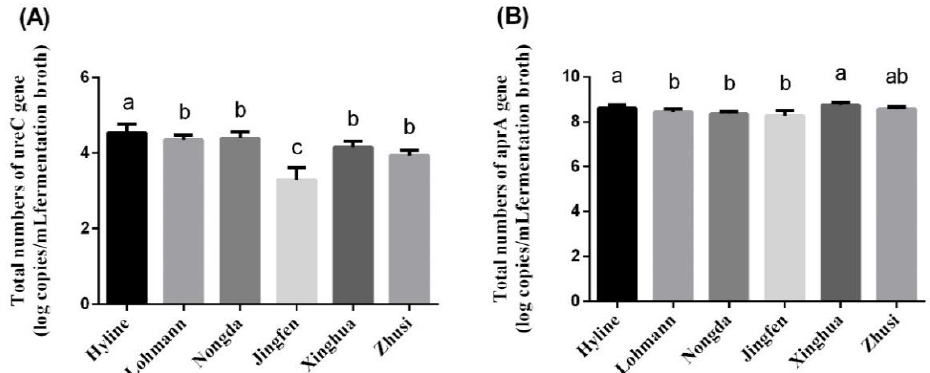
Figure 3. The quantitation of the gene ureC and gene aprA in six laying hen species ( n = 5). ( A ) Total number of ureC genes. ( B ) Total number of aprA genes. Superscript letters a-c indicate differences between means within each species ( p < 0.05).